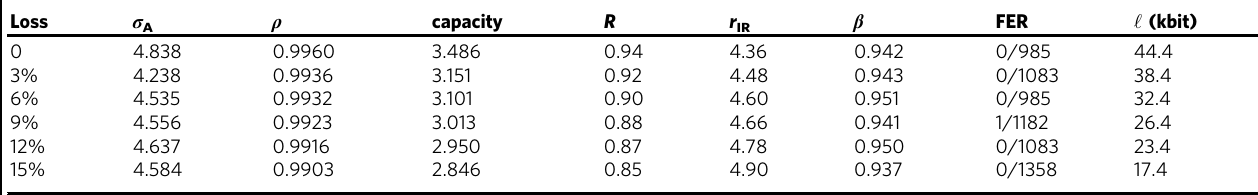
Table 1 Parameters for information reconciliation and privacy ampli fi cation